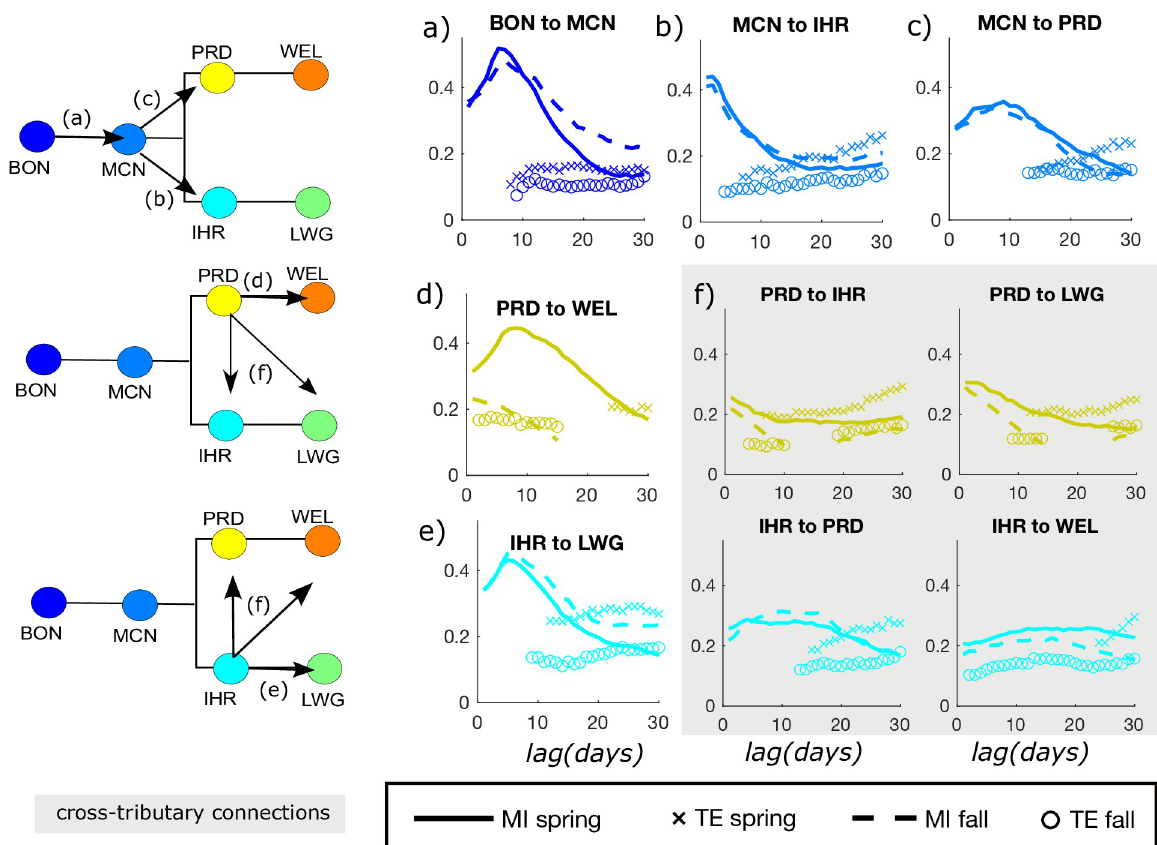
Fig 5. Downstream to upstream (a-e) and cross-tributary (f) MI and TE (units of bits/bit ) between daily salmon counts. Network map icons on the left side of the figure indicate links associated with each plot on the right. In each plot, the horizontal axis indicates the time lag, τ (days) between the source (the downstream dam) and target (upstream dam), and the vertical axis is the fraction of reduced uncertainty of salmon counts at a given dam, or MI (or TE ) divided by the total uncertainty, H ( X ), shown in Table 2. Since TE is conditioned based on dominant tar , t time lags between the target dam and BON (shown in Fig 4), values of TE are not computed until that lag time. Otherwise, gaps indicate non- statistically significant values. Gray shaded plots (f) indicate cross-tributary connections, where salmon do not actually migrate from one dam to